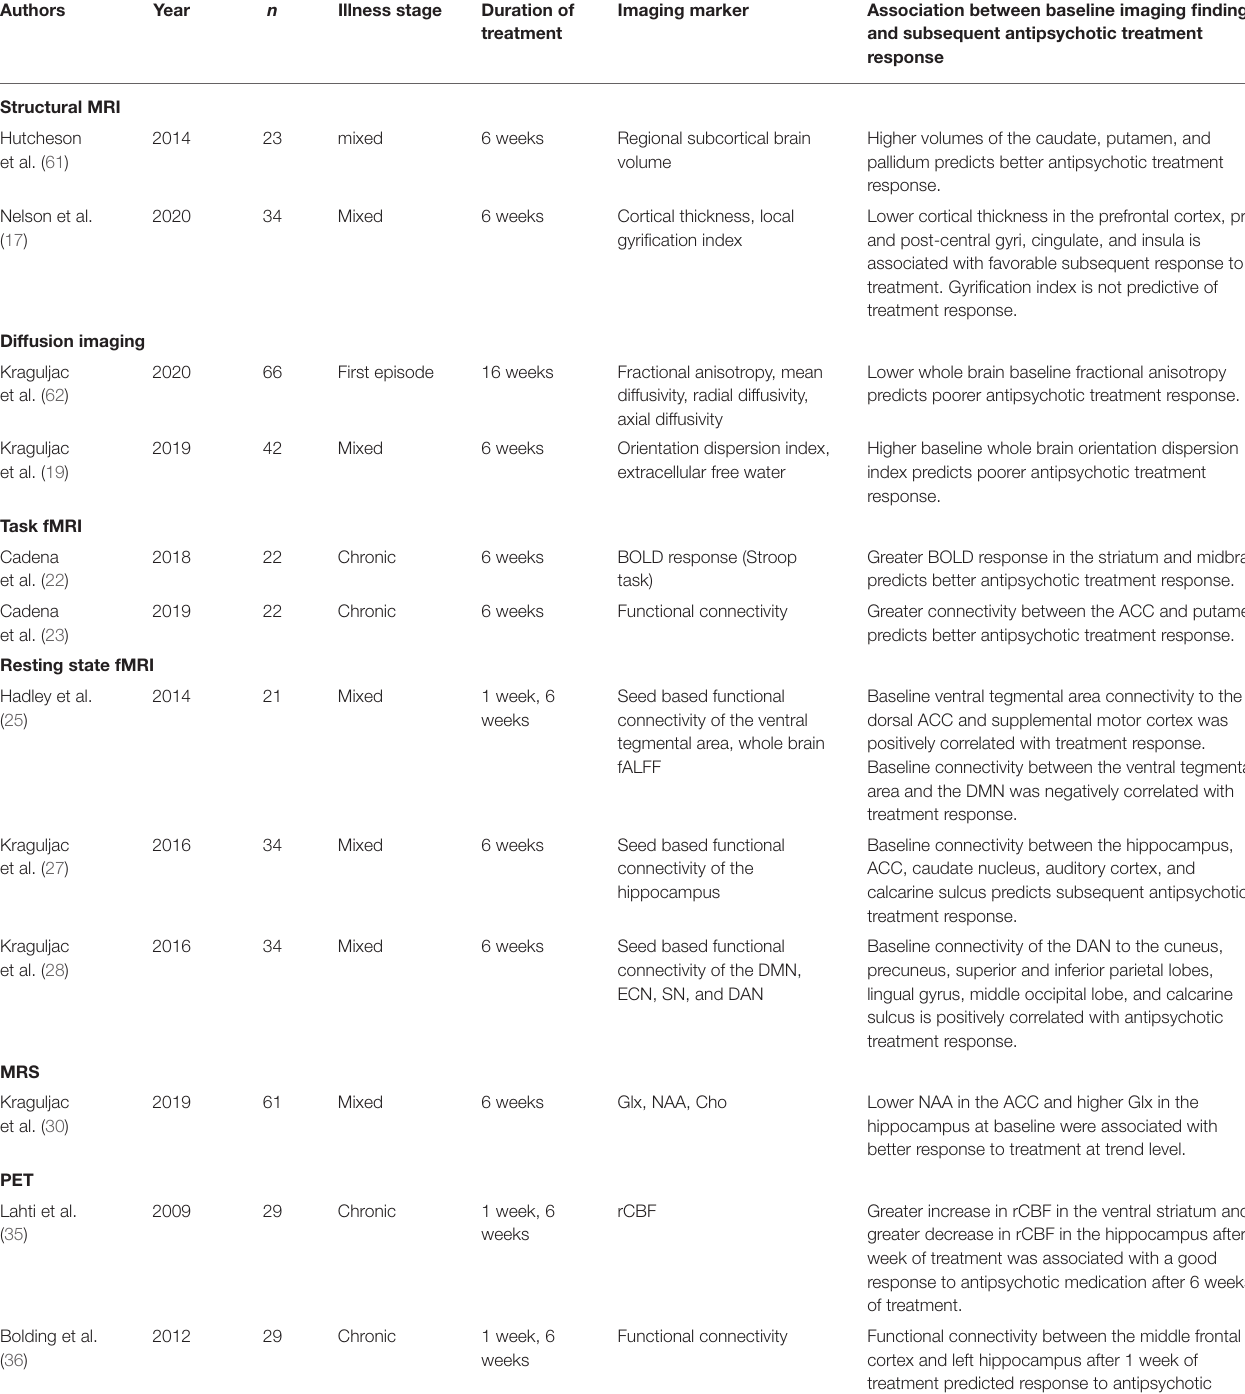
TABLE 2 | Selected baseline neuroimaging markers that are relevant to the prediction of subsequent antipsychotic drug response. Authors Illness stage Duration of